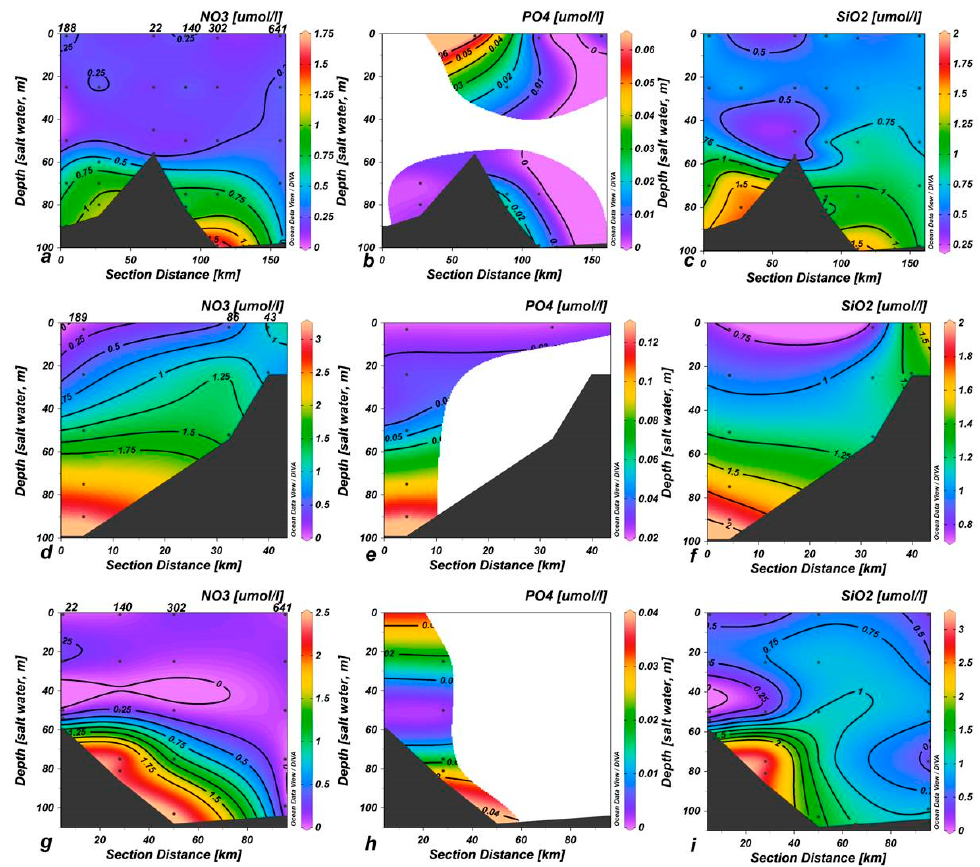
Figure 1. Vertical sections of nitrates, phosphates and silicates (µmol L − 1 ) related to different oceanographic cruises. Specifically, section ( a – c ) refer to BANSIC 2012; ( d – f ) to BANSIC 2013; ( g – i ) to NOVESAR 2013.